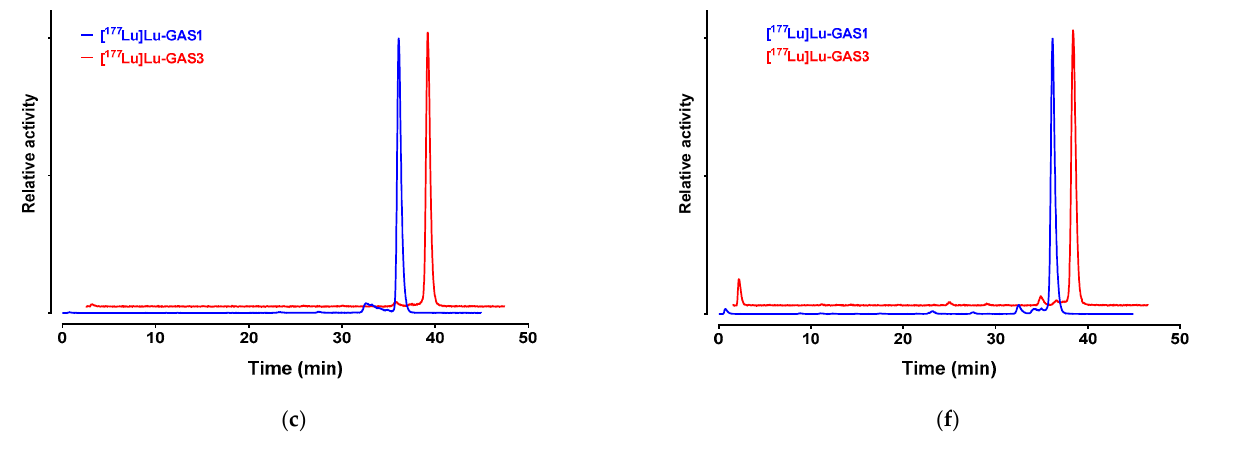
Figure 3. Representative radiochromatograms (system 2) revealing radioligand degradation in mice blood collected 5 min pi for ( a ) [ 67 Ga]Ga-GAS1/2/3, ( b ) [ 111 In]In-GAS1/2/3 and ( c ) [ 177 Lu]Lu-GAS1/3 and in urine collected 30 min pi for ( d ) [ 67 Ga]Ga-GAS1/2/3, ( e ) [ 111 In]In-GAS1/2/3 and ( f ) [ 177 Lu]Lu-GAS1/3. Table 2. In vivo degradation of radioligands in mice blood and urine. Radiometal